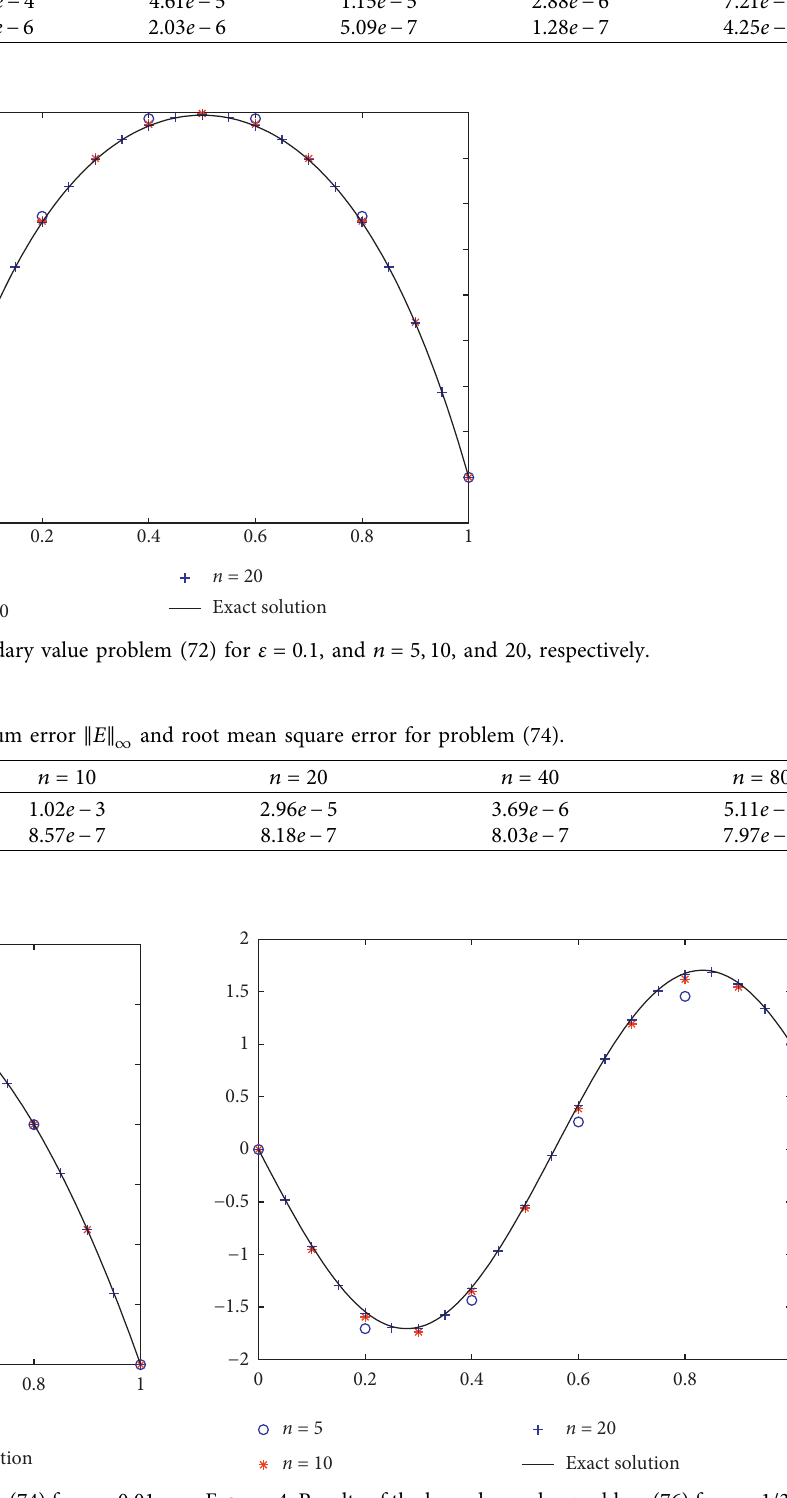
Figure 3: Results of the boundary value problem (74) for ε � 0 . 01, and n � 5 , 10, and 20, respectively.